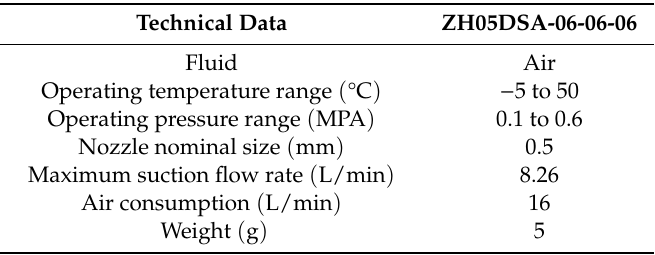
Table 2. Ejector specifications.